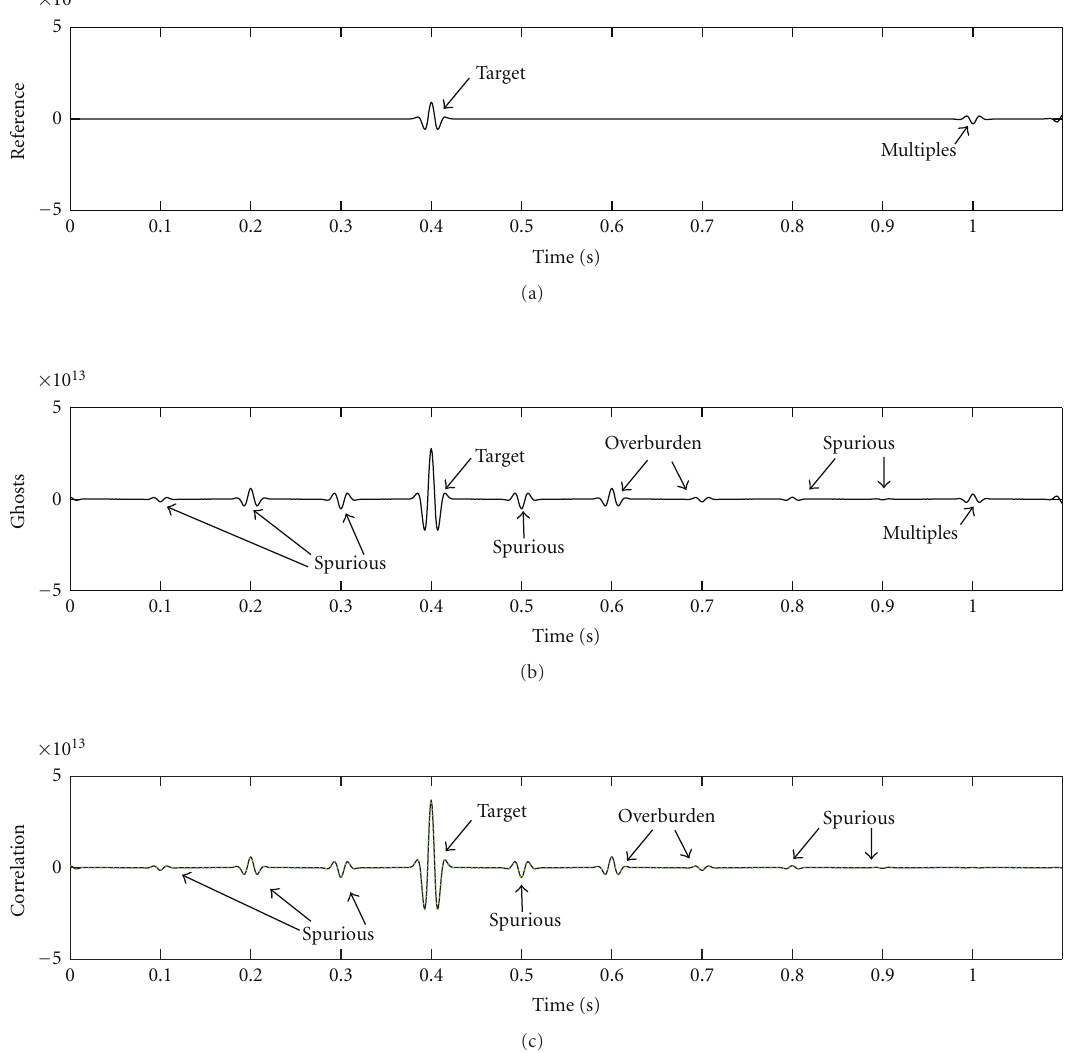
Figure 10: Cross-correlation of perturbed fields for model D: (a) reference response by placing an active source at the virtual source location + g E ; (c) correlation function C ptb (black) and the sum of reference response + ghosts (dashed x A ; (b) computed ghost terms g S ptb ptb